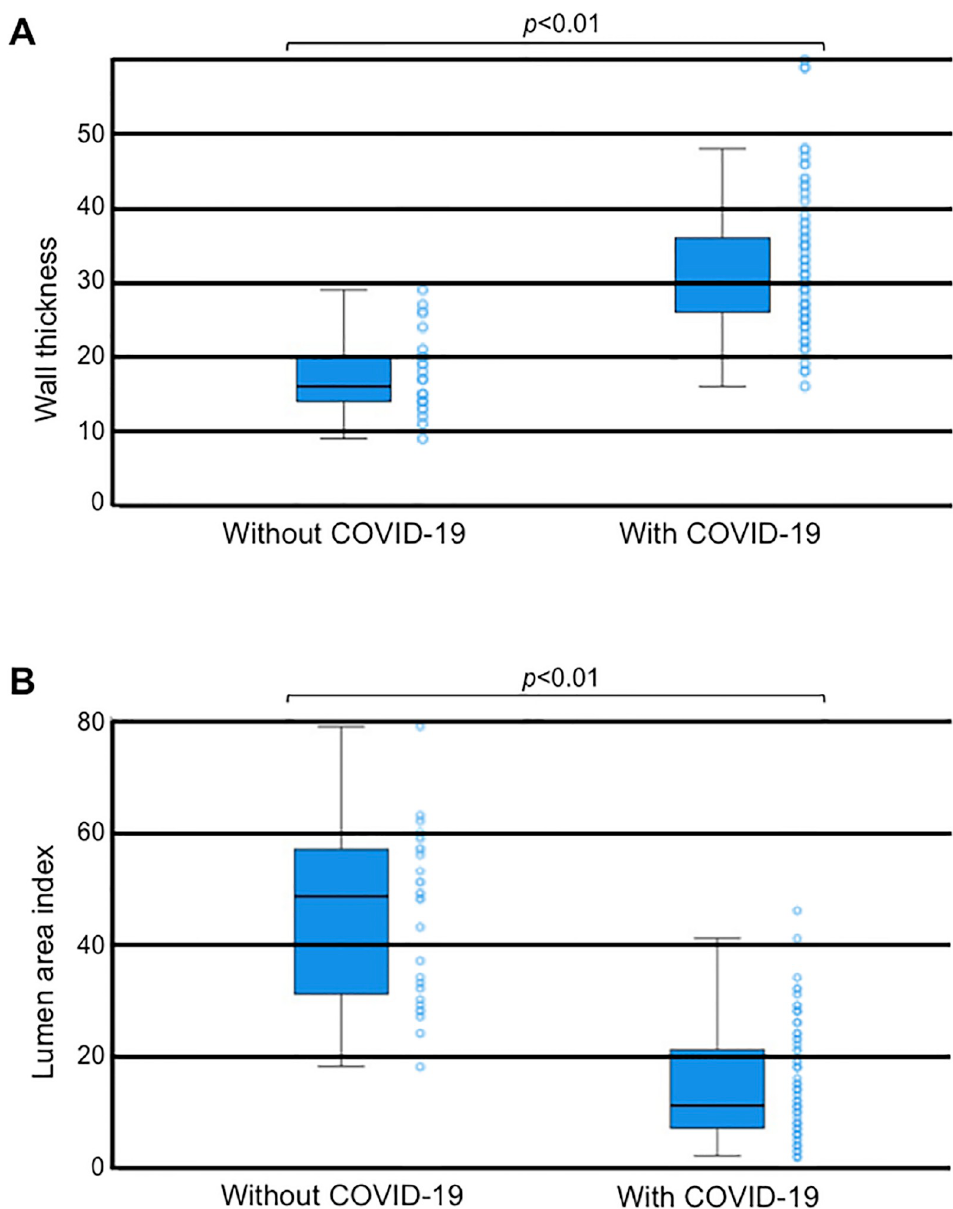
Fig 2. Morphometric analysis of the placental arterial wall thickness in women who gave birth without or with COVID-19. Box plots represent (A) vascular wall thickness and (B) the lumen area index values. N = 28 for control and N = 85 for COVID-19. Mann-Whitney U test indicated that the two values are significantly different at p <